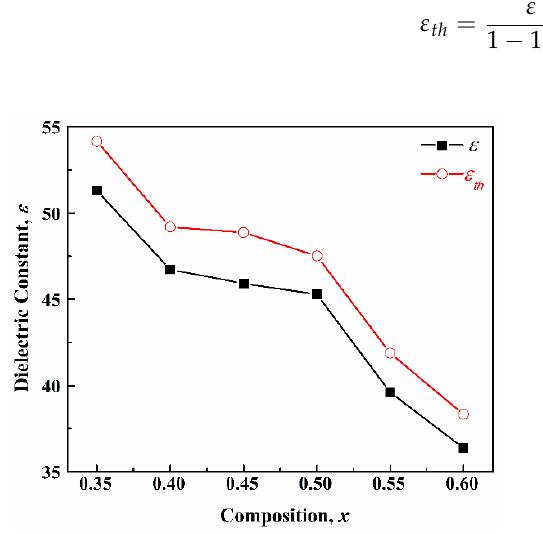
Figure 6. ε and ε th of the (1– x )CLT- x NMT ceramics.